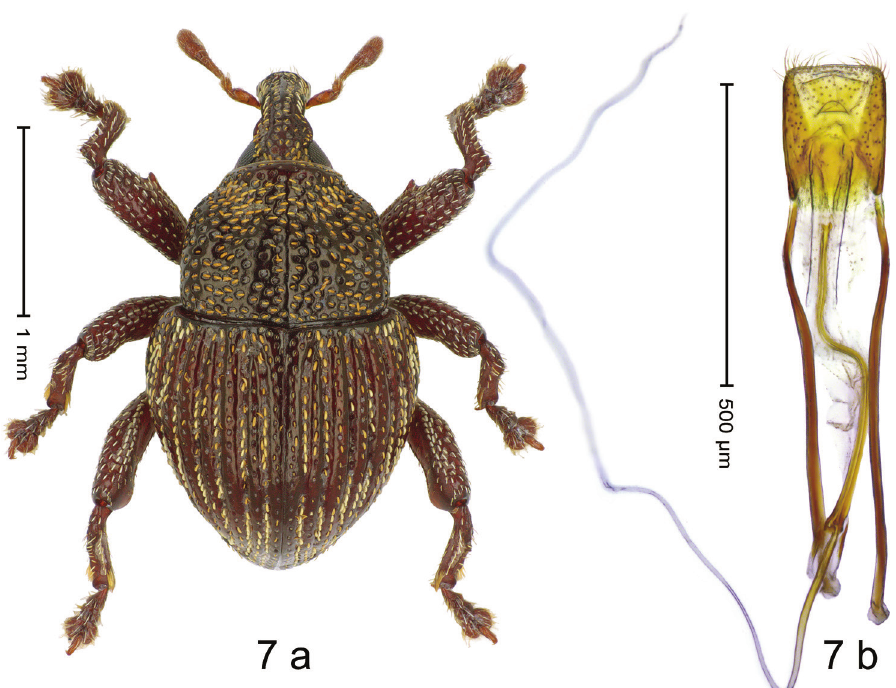
Figure 7. Trigonopterus ewok sp. nov., holotype a habitus b